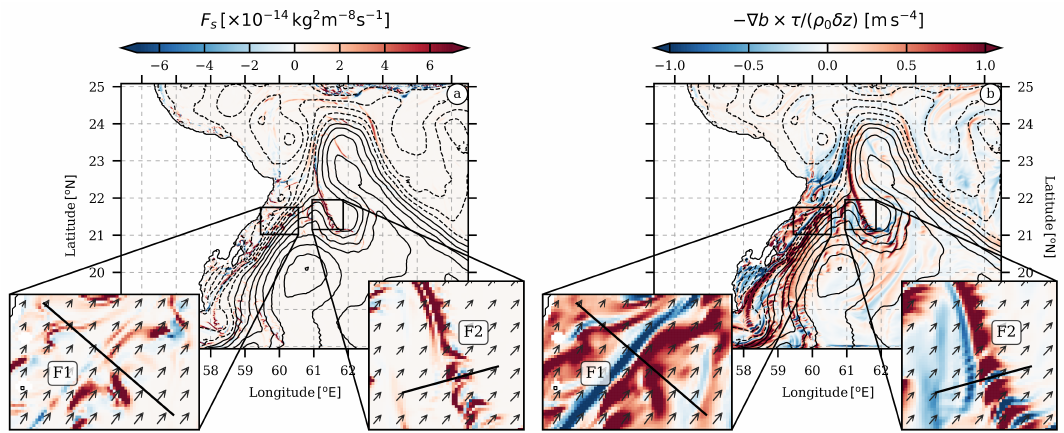
Figure 3. ( a ) Surface frontogenesis function and ( b ) the PV injection by the wind. The wind stress vectors are drawn in